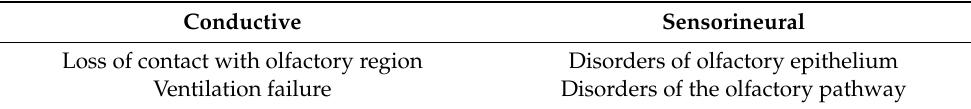
Table 2. Disorders of smell by etiopathogenesis.